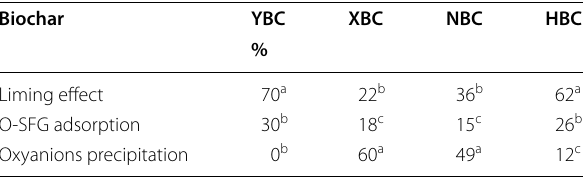
Means followed by the same letter within columns are not significantly different ( P 0.05) =